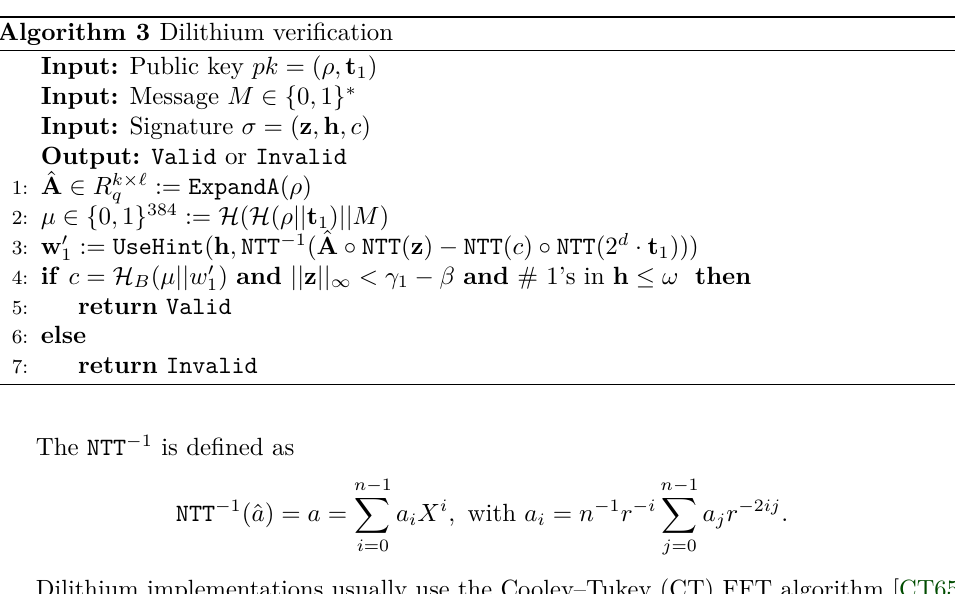
Algorithm 3 Dilithium